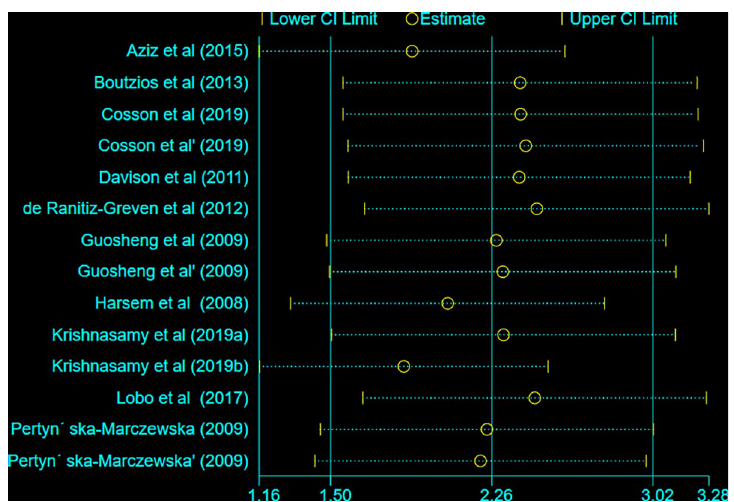
Fig 9. Meta-influence plot showing the impact of every study on the overall SMD